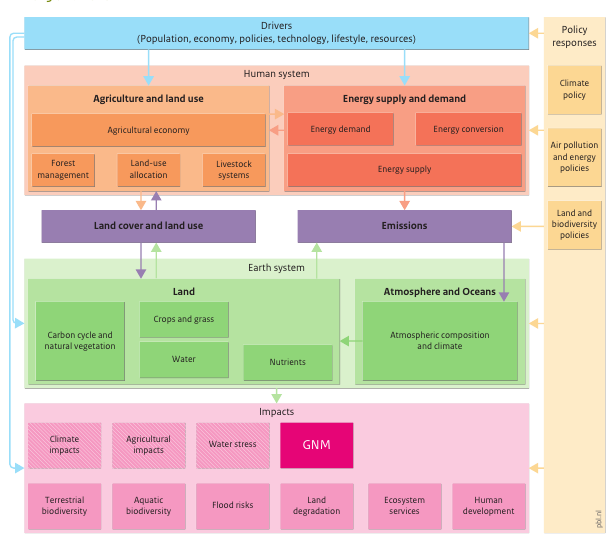
Figure 1. Scheme of the Integrated Model to Assess the Global Environment (IMAGE) modified from Stehfest et al.